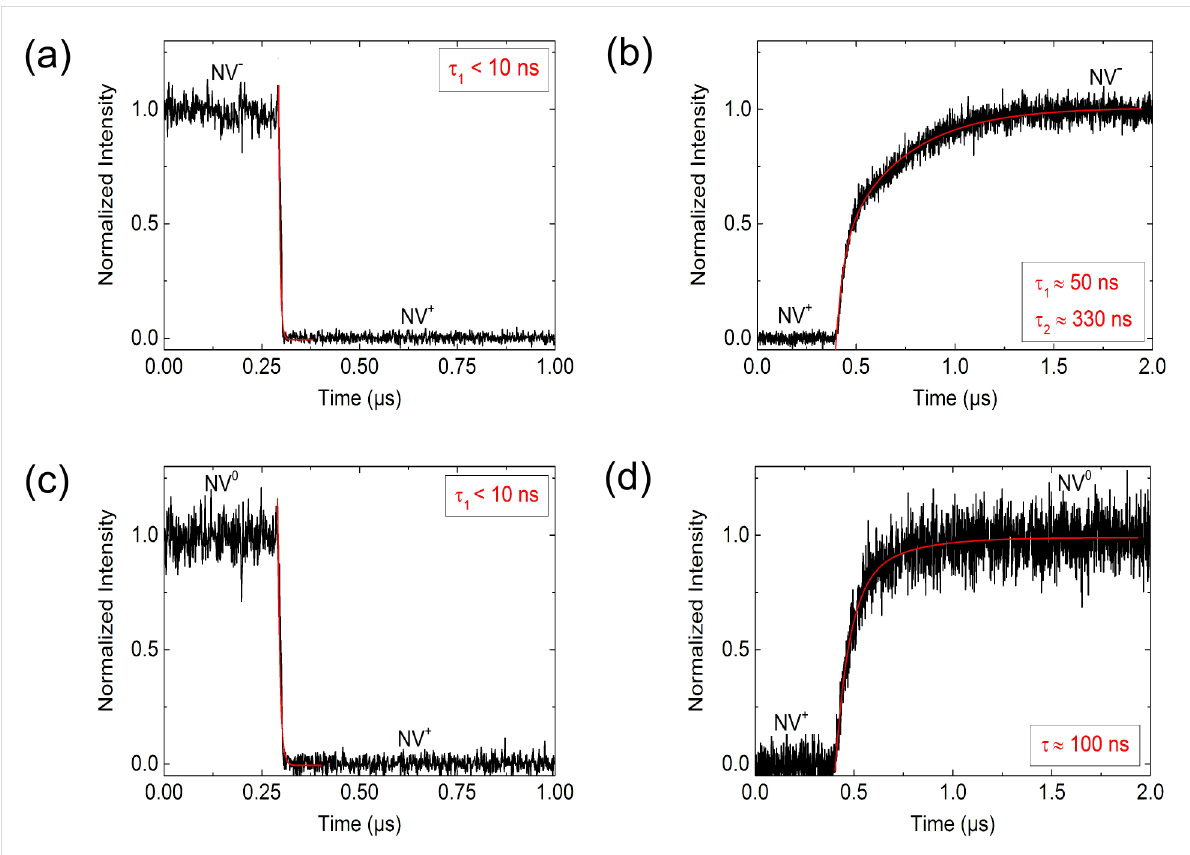
Figure 6: Time constant for charge state switching. Time constants deduced from fitting an exponential function to the decay and rise of NV-intensity for the transitions (a) NV − → NV + (b) NV + → NV − (c) NV 0 → NV + as well as (d) NV + → NV 0 . Since the time resolution of this measurement is in the range of 1–10 ns, the deduced time constants in (a) and (c) are upper limits. According to the measured time constants, a switching rate between 1 MHz (charging NV) and 100 MHz (discharging NV) seems to be possible. This is much faster than the rate of hyperfine interaction between an elec- tron and nuclear spin of A // = 2.66 kHz.